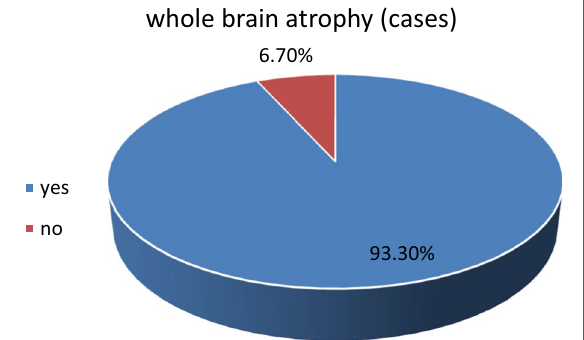
Fig. 3 Diagramatic representation of percent of patients with whole brain atrophy